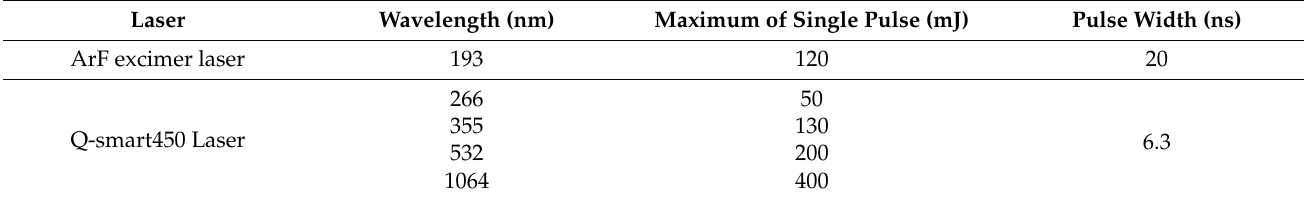
Table 1. Selected laser parameters.